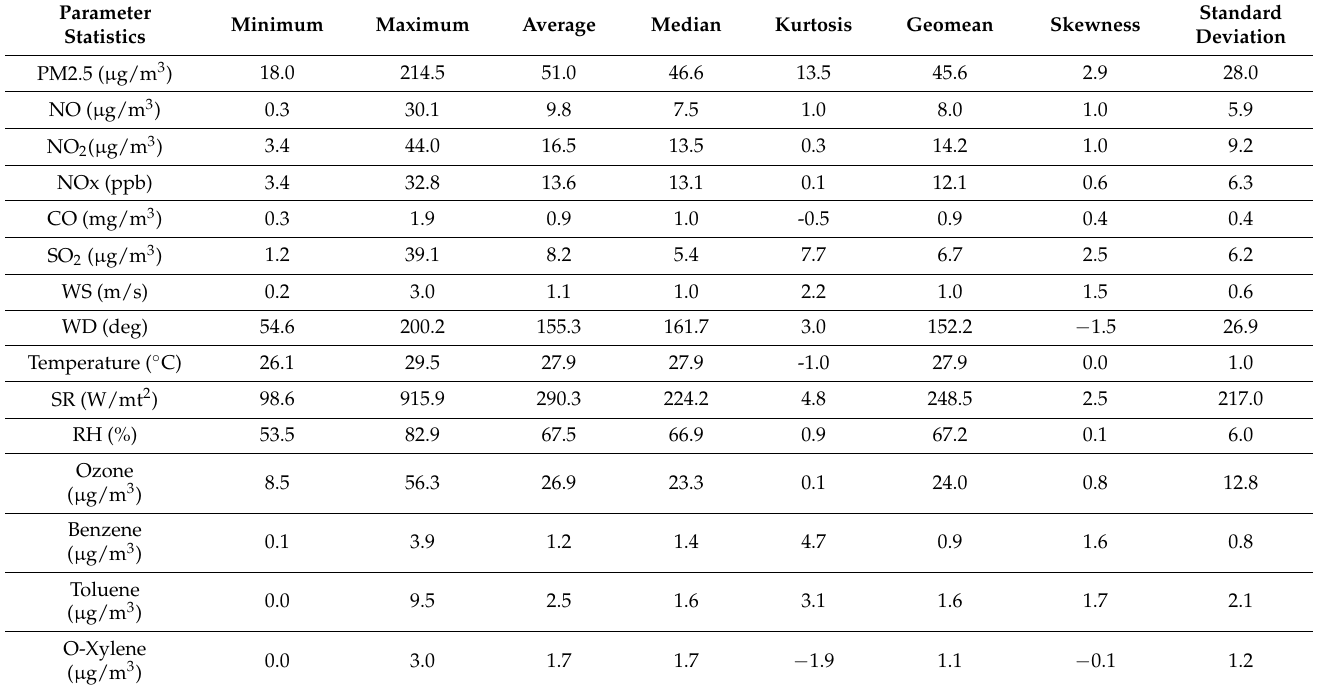
Table 2. Basic geostatistical summary of outdoor environmental air pollutants in the Chennai